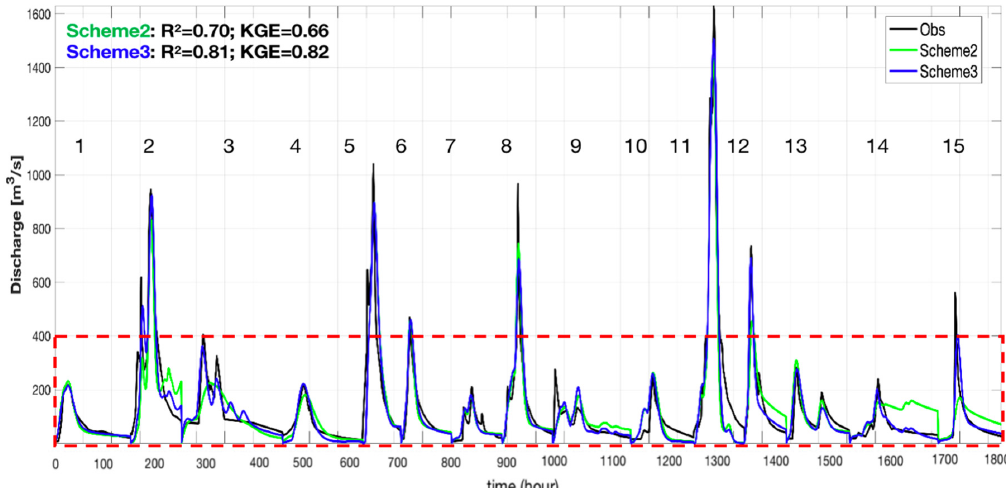
Figure 7. Comparison between observed and simulated streamflow accounting for W_max calibration (S3) versus without W_max calibration (S2). The dashed red box highlights significant improvements of base-flow simulation from scheme 2 versus scheme 3.